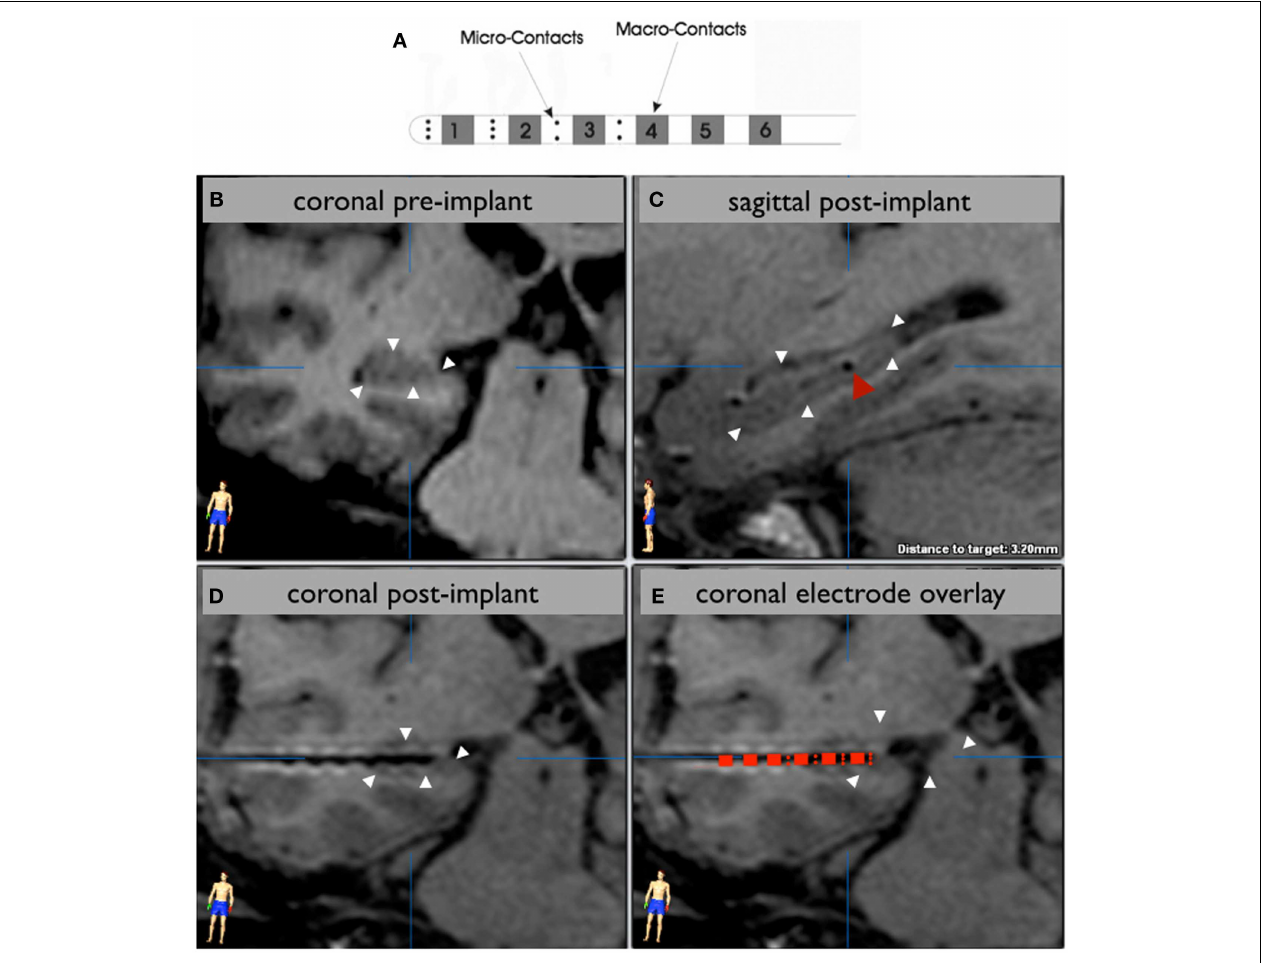
hippocampal body. A schematic of the electrode is overlaid on the contact artifacts in a magnified coronal view (E) to demonstrate which contacts are sampling the hippocampus. In this case, the distal eight micro-contacts and the distal two macro-contacts are within the hippocampus.The distal third macro-contact is located at the lateral border of the